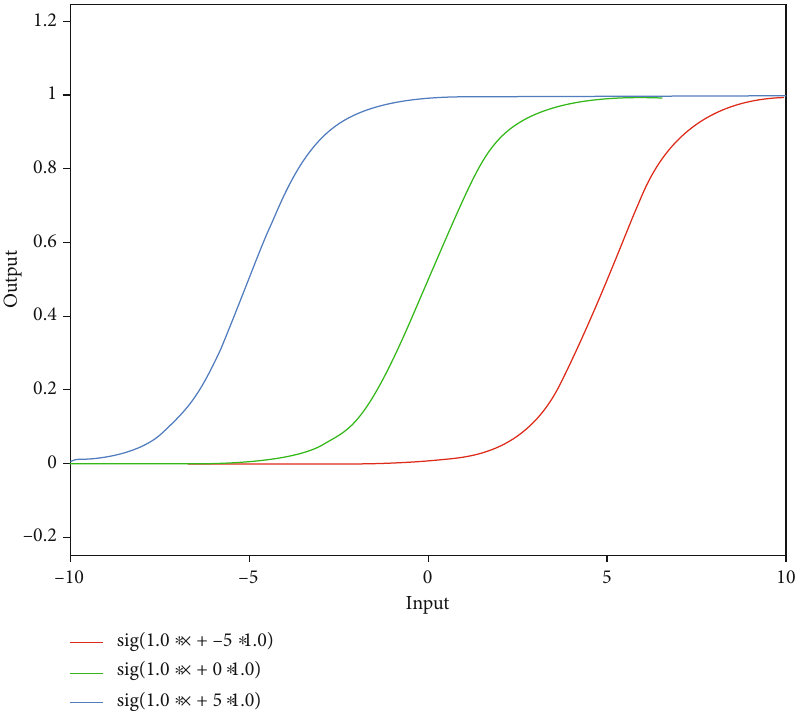
Figure 3: The sigmoid function result with various input weights with